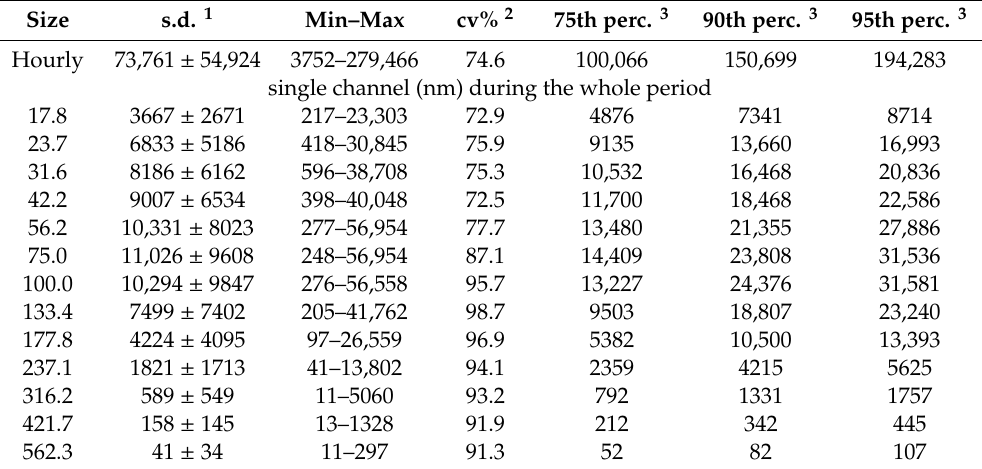
Table 1. Particle levels (cm − 3 ) in the range 18–750 nm (13